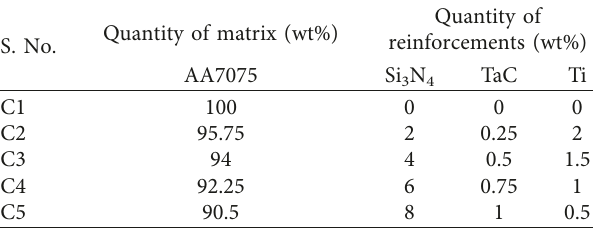
Table 3: Control factors – stir casting process. S. No.